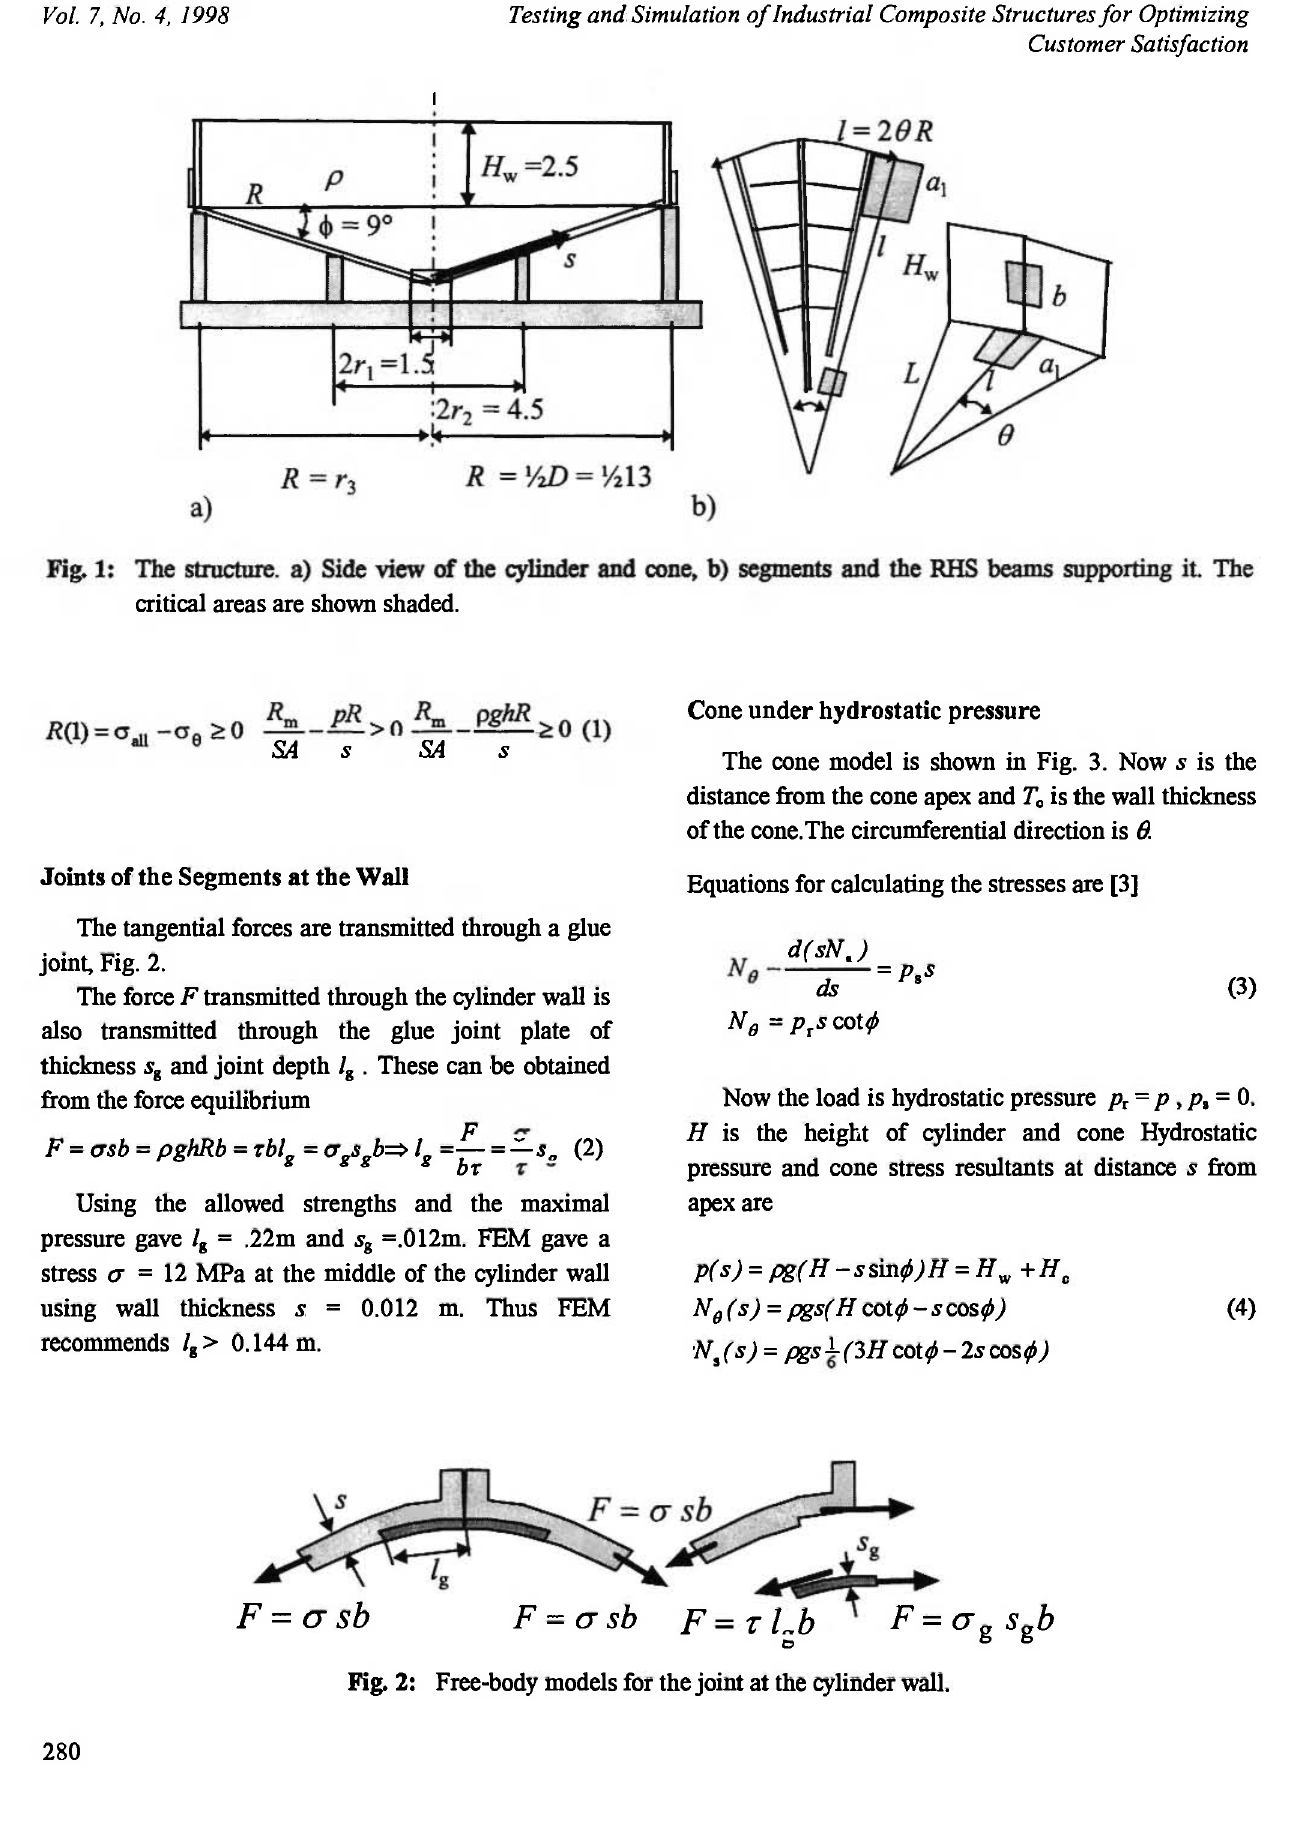
Fig. 2: Free-body models for the joint at the cylinder